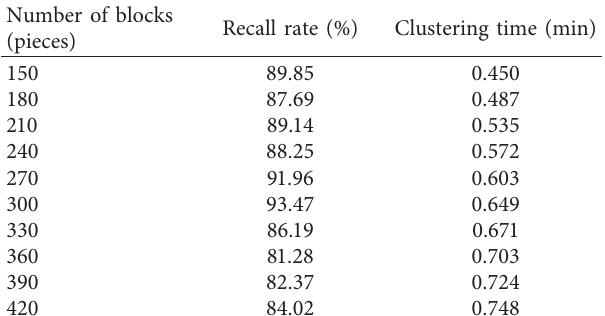
Table 3: The image redundancy processing results of Method 2.